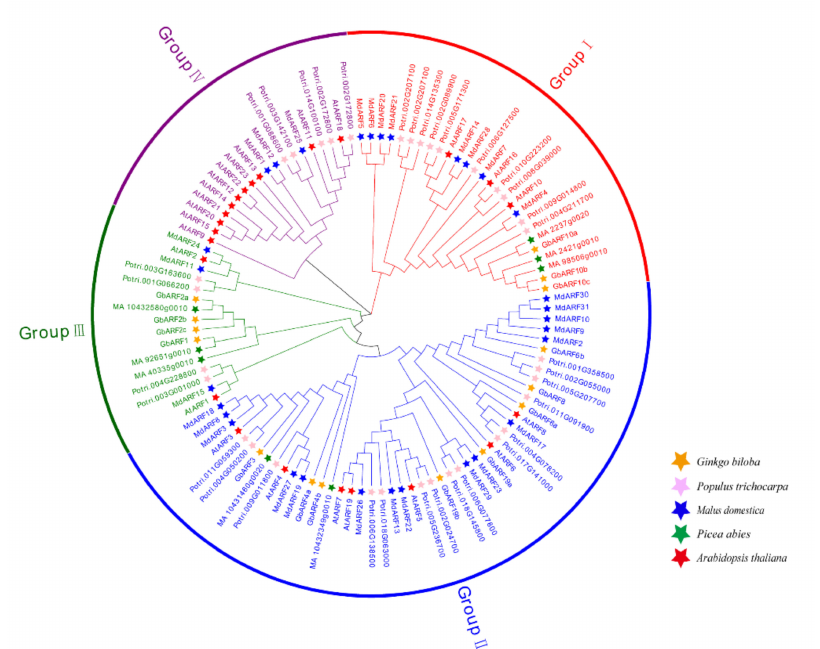
Figure 1. Phylogenetic tree of the ARF gene family in Ginkgo biloba , Populus trichocarpa , Malus domestica , Picea abies , and Arabidopsis thaliana . GbARF members of five species marked with different colored